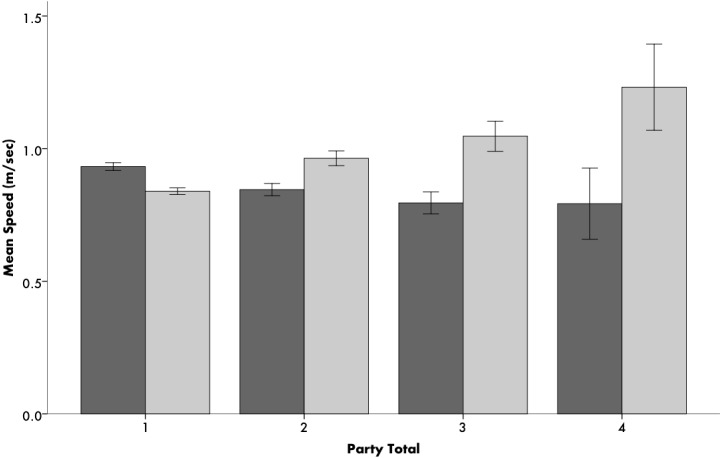
Average speeds of Ugandans (dark grey) and Americans (light grey) based on walking group size (x-axis refers to number of people walking in the group).Error bars indicate 95% CI.